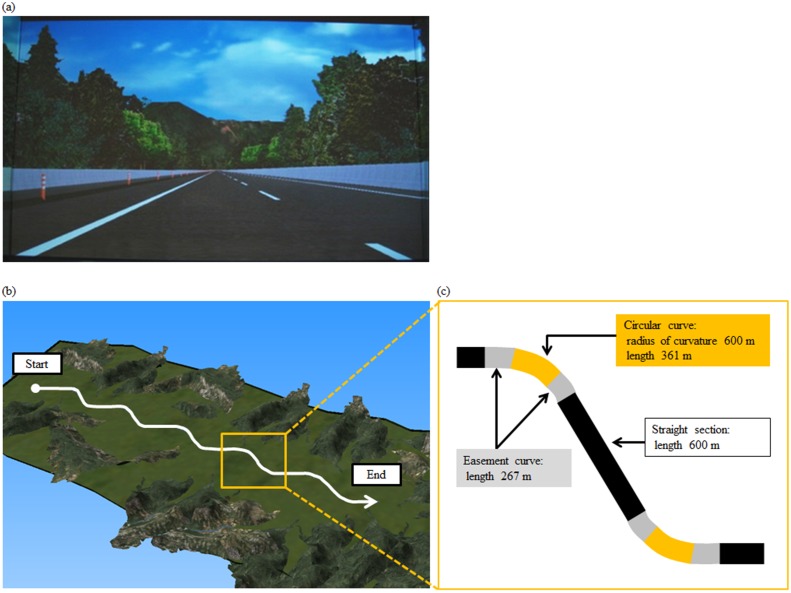
Experimental course.(a) Starting point. (b) Overview of entire course. (c) Schematic view of a left curve and a right curve. The course comprised 5 of these right/left curve sections.